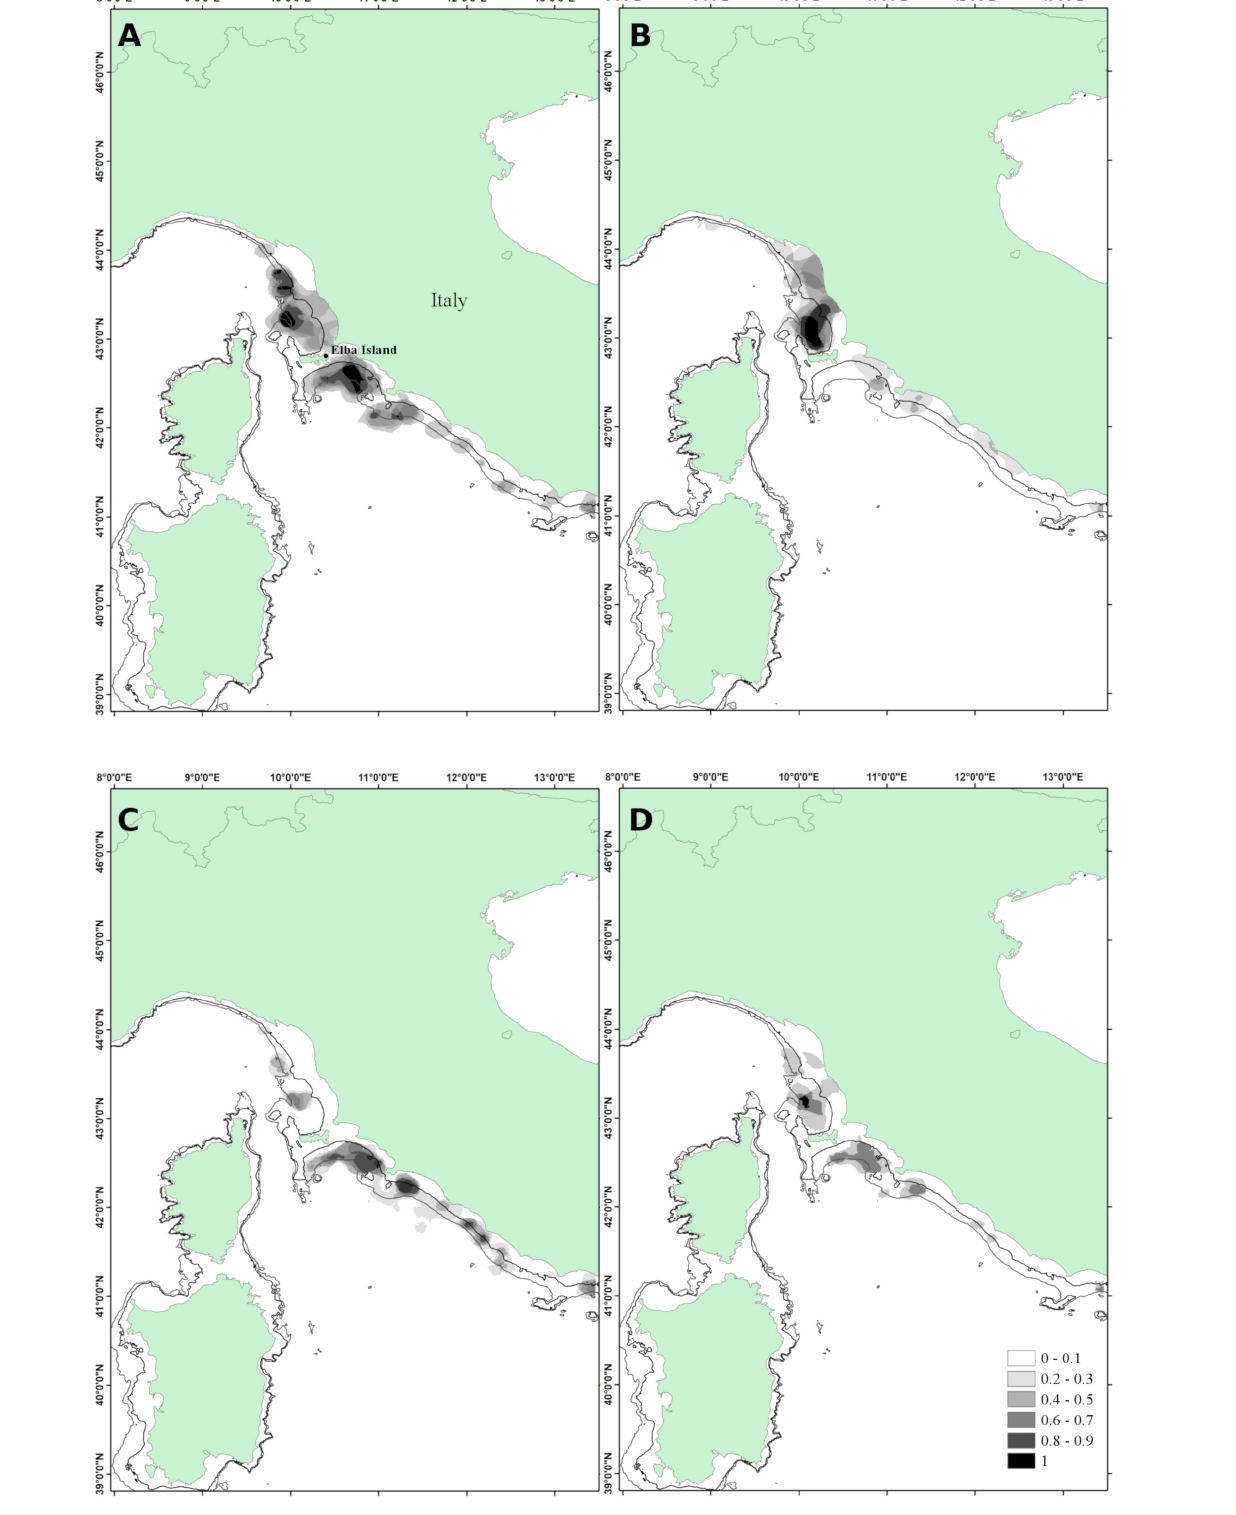
Frontiers in Marine Science |